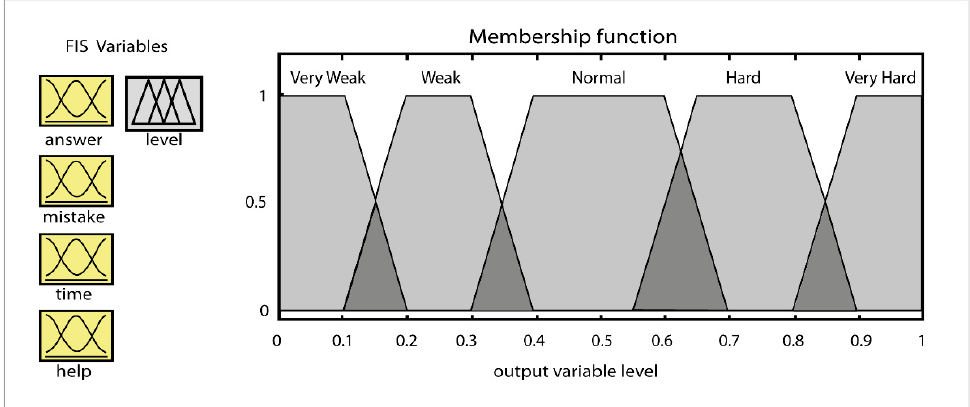
Figure 2. Fuzzy set example of the answer, mistake, time, help, and